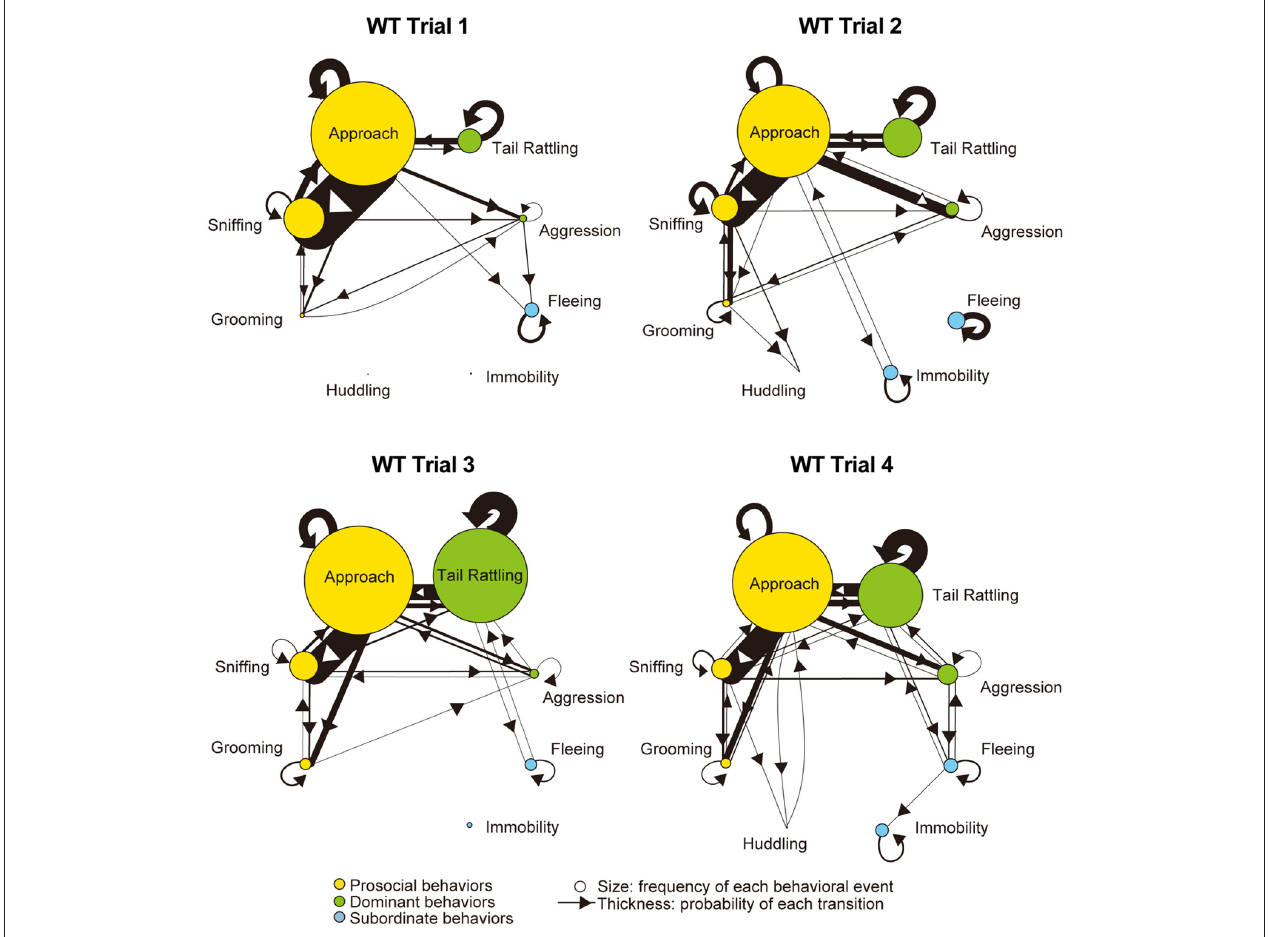
FIGURE 3 | Kinetograms for monad behavioral transitions of WT mice in each trial. The diameters of circles were calculated for each genotype and trial using the following formula. Circle diameter is proportional to (Total number of each behavioral event)/(Total number of all behavioral events within each genotype and trial). Type of behavioral events (prosocial, dominant or subordinate) were indicated by circle color. Width of the arrows were also calculated using the following formula. Arrow width is proportional to (Total number of each transition)/(Total number of all transitions within each genotype and trial). Arrowhead indicates direction of each